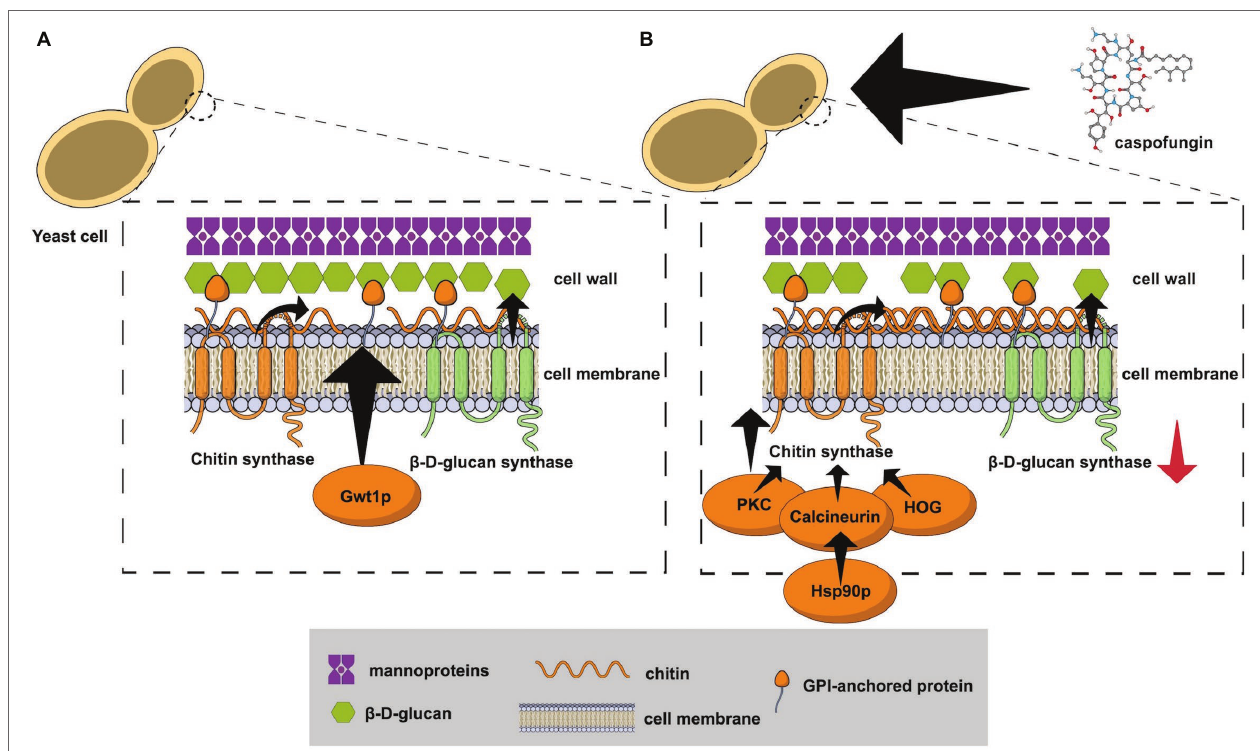
FIGURE 1 | (A) The fungal cell wall and the targets that have been explored for antifungal development: β -D-glucan synthase, chitin synthase, and the enzyme Gwt1 from the GPI anchor pathway; (B) Echinocandin exposure causes cell wall stress by inhibition of the β -D-glucan synthase. The protein kinase C (PKC), high osmolarity glycerol response (HOG), and Ca +2 -calcineurin pathways have been implicated in the response to cell wall damage and chitin synthase hyper stimulation. Calcineurin is a client protein for the Hsp90 chaperone and genetic compromise of the gene HSP90 reduces the tolerance